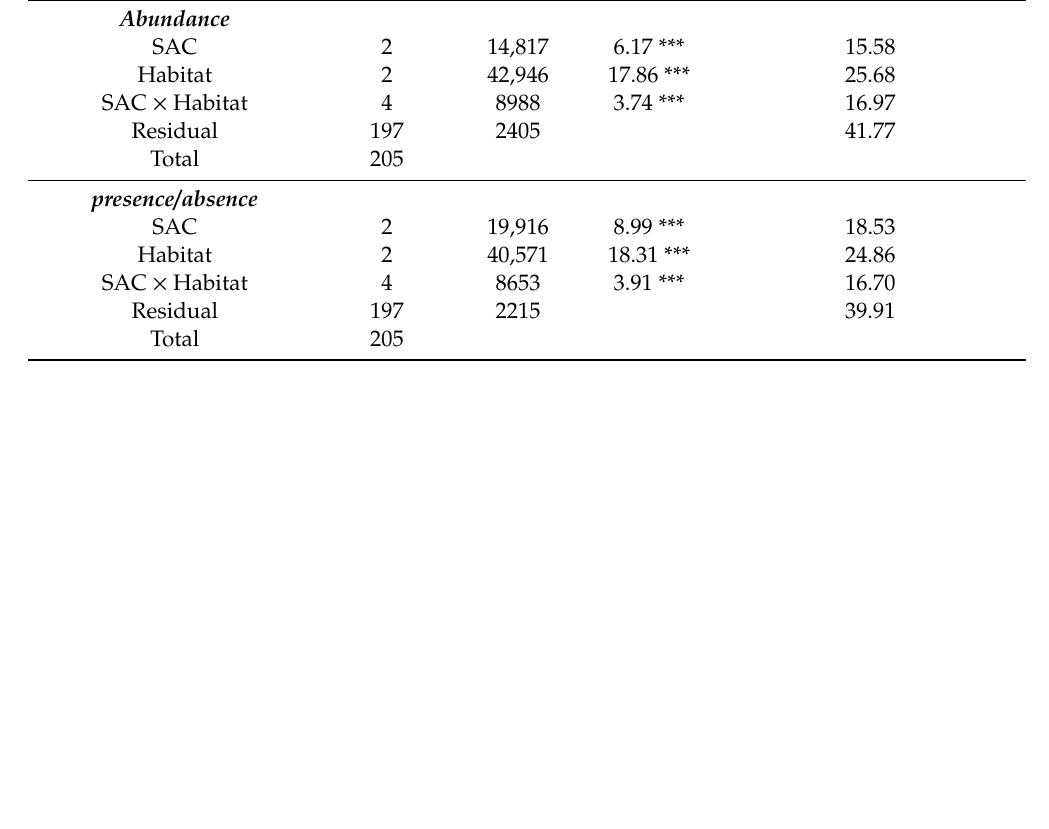
Figure 3. Additive partitioning of diversity (% of total species richness) in each sampling site across different spatial scales (within plot—α plot; habitat—β plot, and site—β hab). A null model was also computed to assess significant departures from random expectations (*** p < 0.001; ** p < 0.01; * p < 0.05). TL = Torre del Lago; PU = Parco Uccelllina; SV = Selva Pisana.